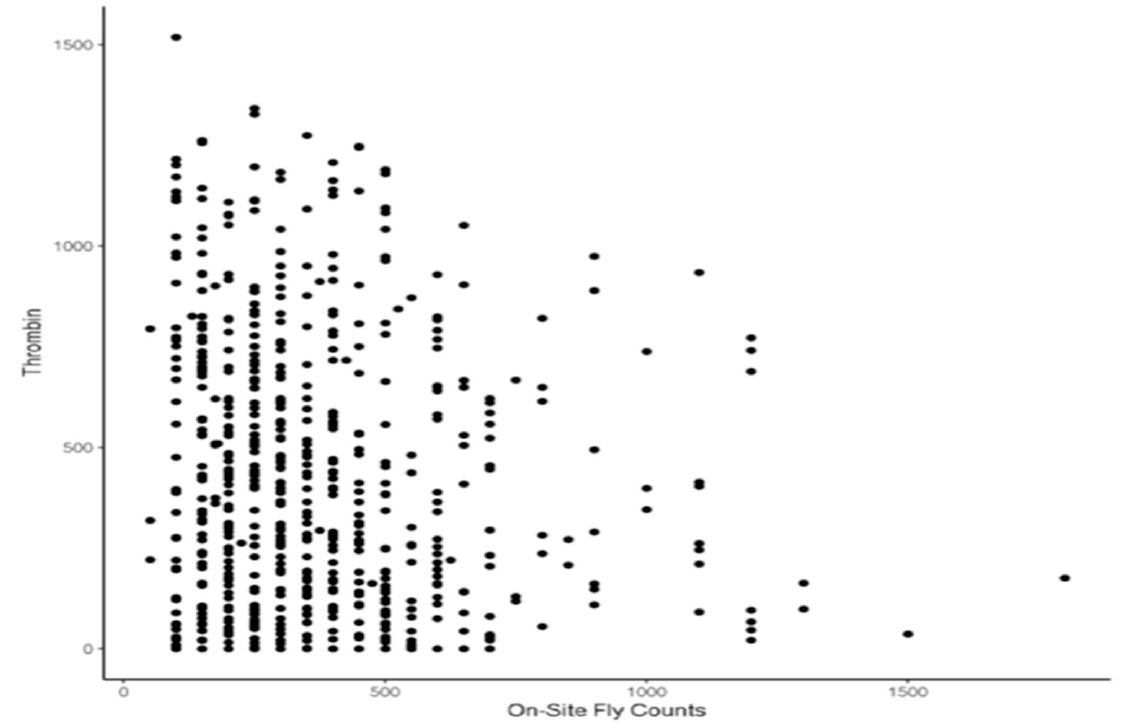
Figure 3. Relationship between fly counts and thrombin concentration.